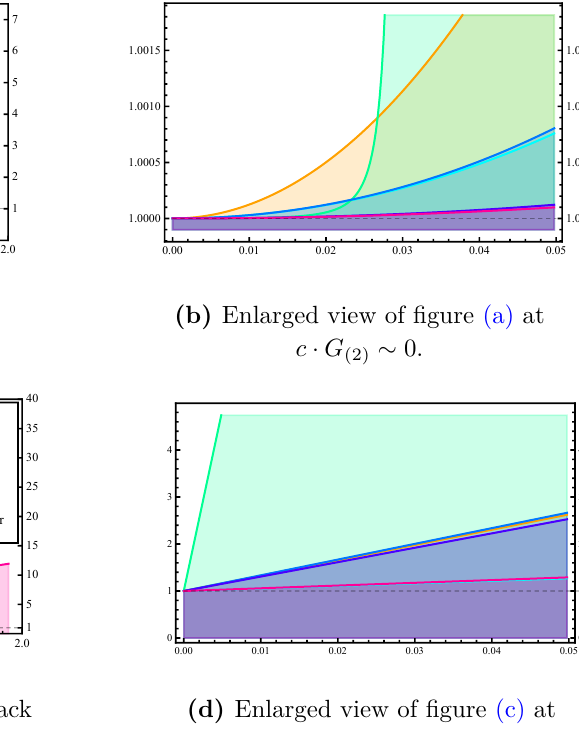
(d) Enlarged view of figure (c) at c · G ∼ 0 . (2) = 10 , λ = 10 − 2 , h